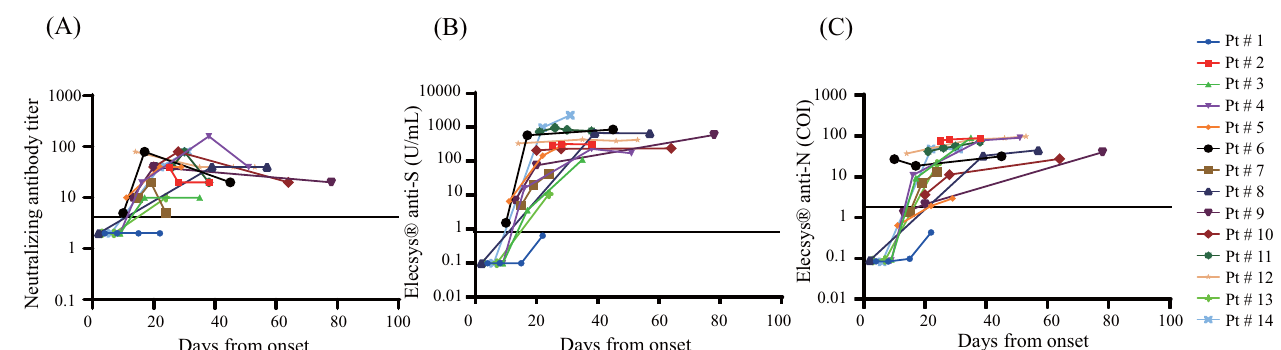
Fig 3. Longitudinal change of antibodies in Group M. Levels of SARS-CoV-2 antibodies in 14 mild to moderate cases (Group M) were tested. (A) Neutralizing antibody (B) Elecsys 1 anti-S (C) Elecsys 1 anti-N. The vertical axes are in logarithmic notation.